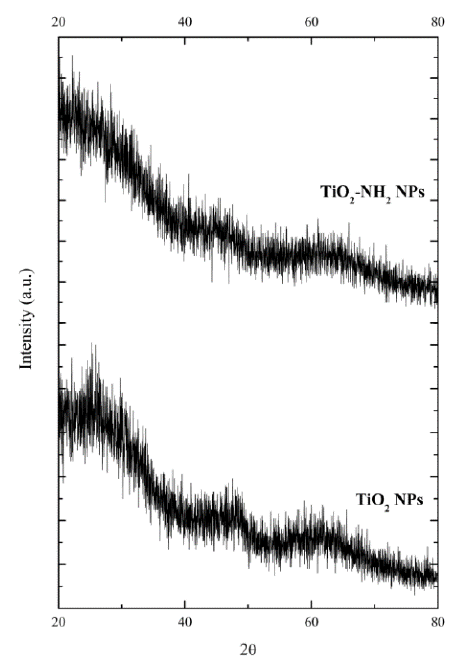
Figure 12. XRD diffractograms of a-TiO 2 -based NPs.